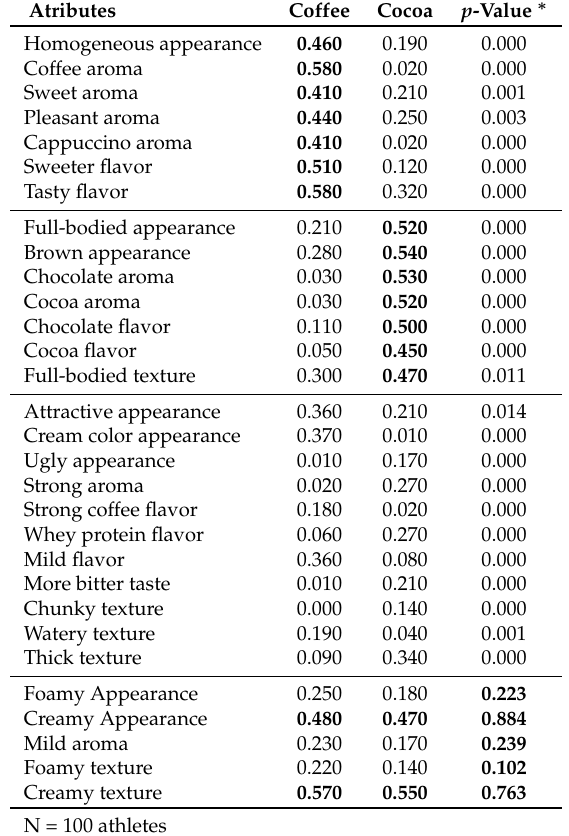
Table 2. Frequency of check-all-that-apply (CATA) attributes for post-workout beverages formulated with coffee or cocoa.